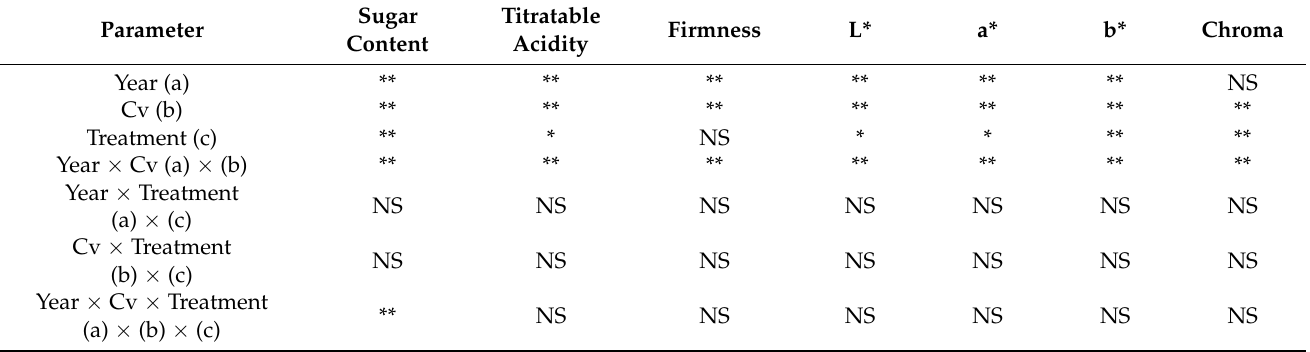
Table 12. Three-way analysis of variance (ANOVA) for the qualitative parameters ** = significant interaction with p < 0.01; * = significant interaction with p < 0.05; NS = not significant